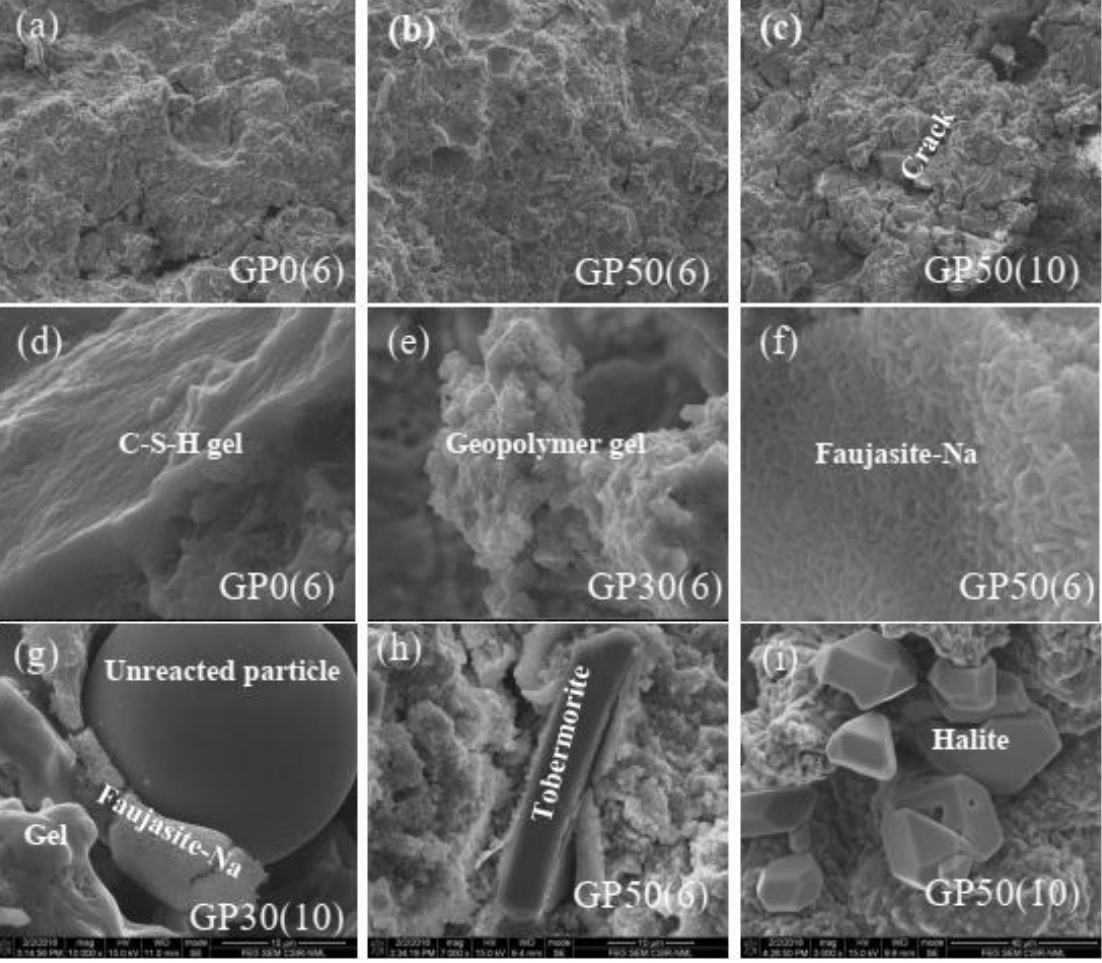
Figure 6. FEG-SEM/EDS analysis of GPX(6) and GPX(10). ( a , d ) micrographs of GP0(6); ( b , f , h ) micrographs of GP50(6); ( c , i ) micrographs of GP50(10); ( e ) micrograph of GP30(6) and ( g ) micrograph of GP50(10).